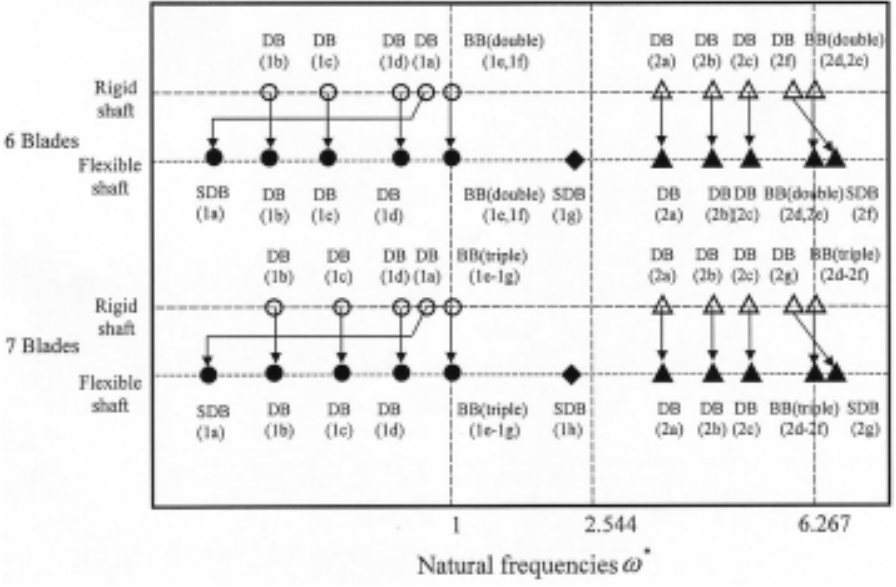
• Blades’ first mode predominates, (cid:5) (cid:1)